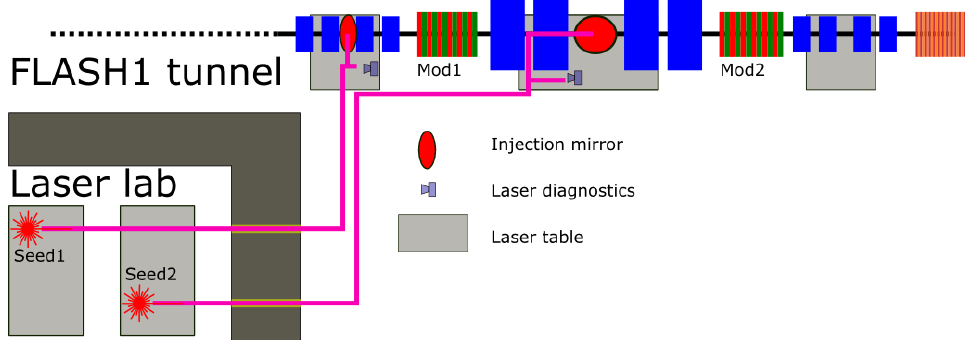
Figure 6. Layout of the laser beamlines (top view) going from the laser laboratory to the two interaction